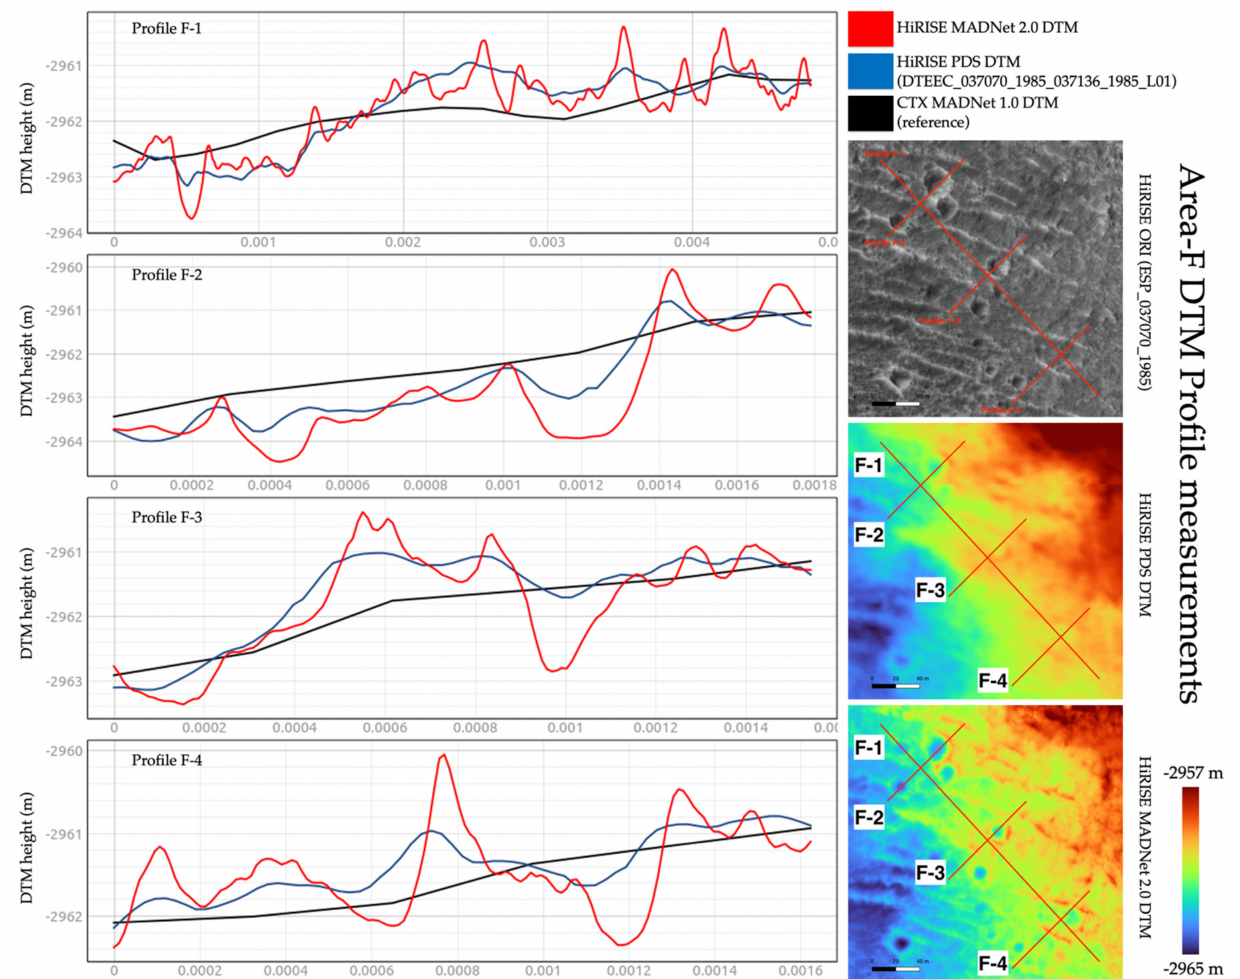
Figure 21. DTM profile measurements of the 1 m/pixel PDS HiRISE DTM, the 25 cm/pixel MADNet 2.0 DTM, and the 12 m/pixel MADNet 1.0 CTX DTMs (the reference DTM) for area-F (location is shown in Figure 10). N.B. all profile measurements begin from the labelled side of the profiles lines that are shown on the image and DTMs to the other end of the